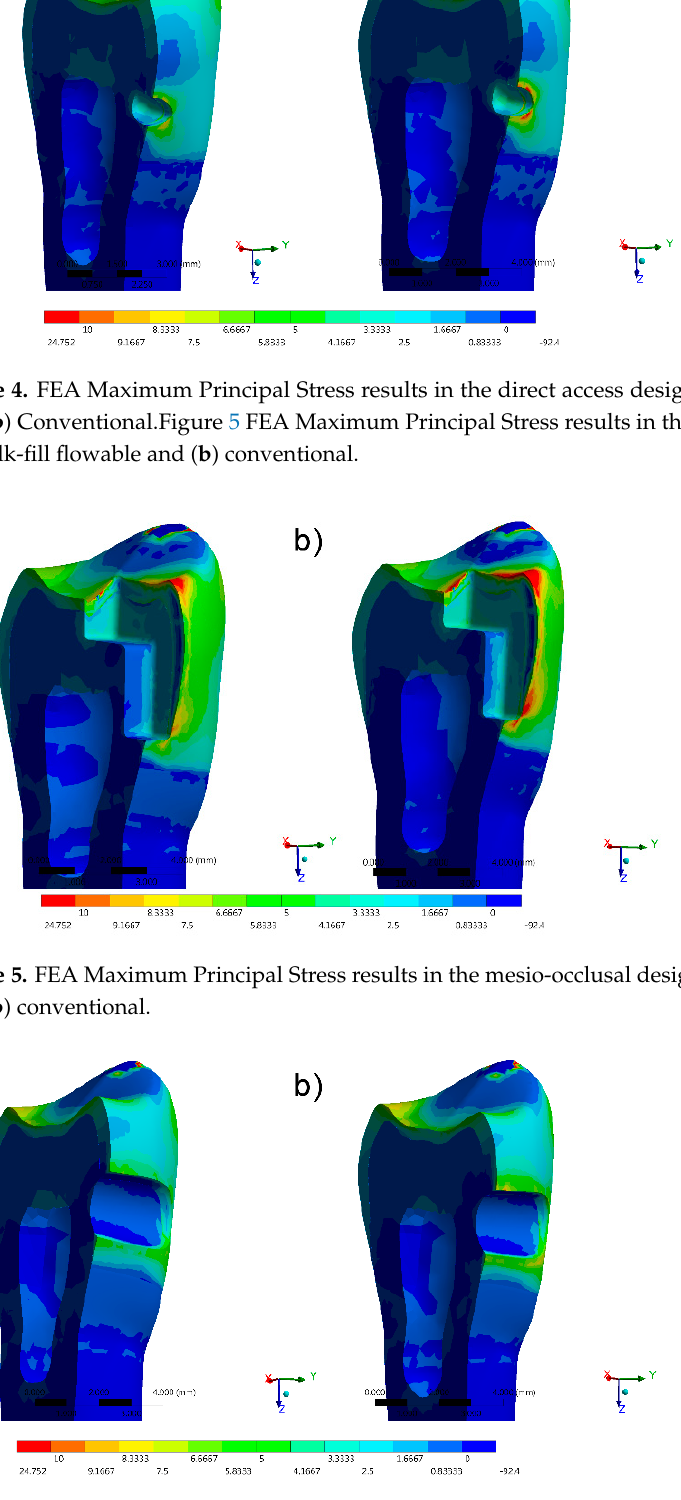
Figure 6. FEA Maximum Principal Stress results in the horizontal slot design. ( a ) Bulk-fill flowable and ( b ) conventional.